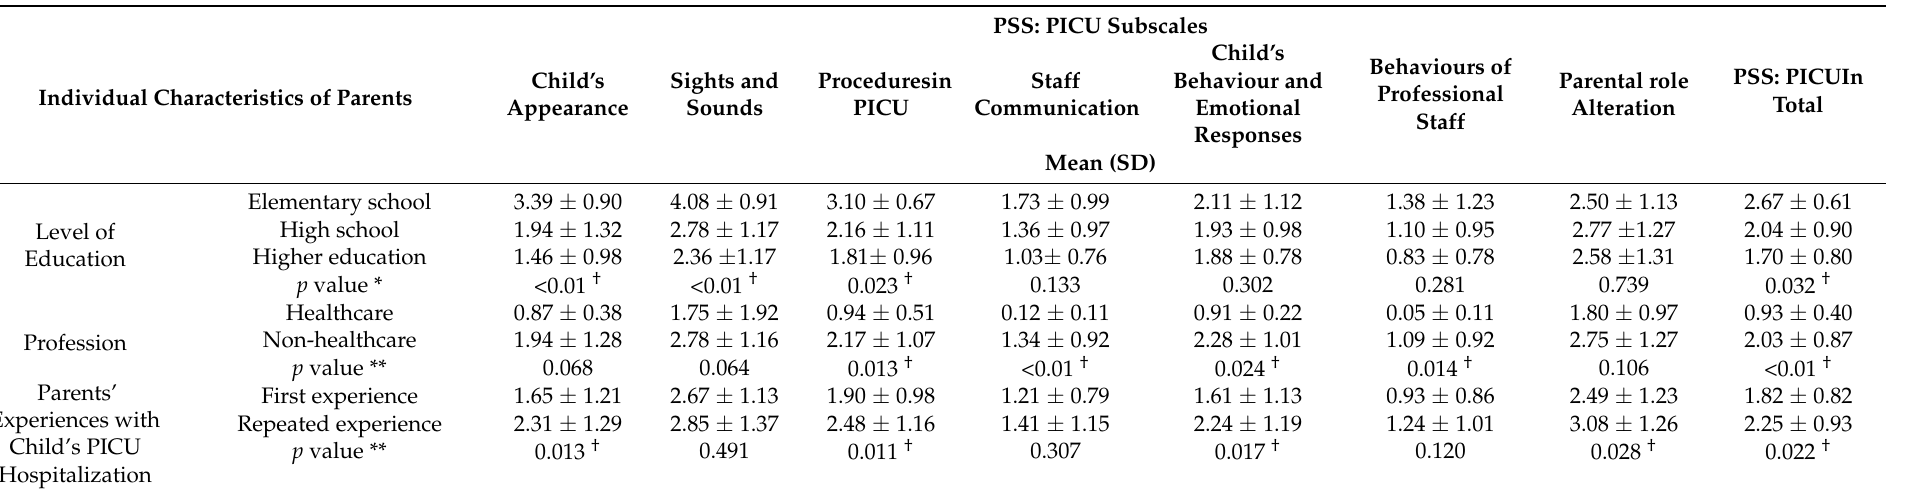
Table 5. The level of perceived stress of parents with regard to their individual characteristics and previous experiences of child’s PICU